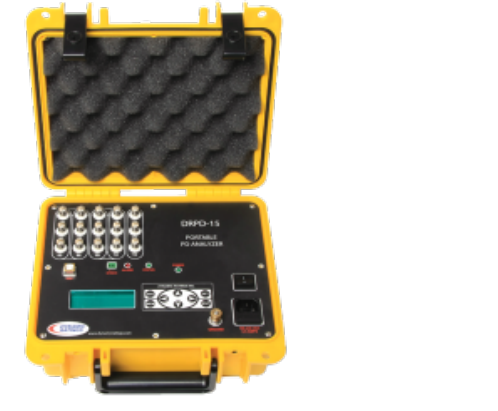
Figure 20. Portable equipment model DRPD-15 of Dynamics Ratings